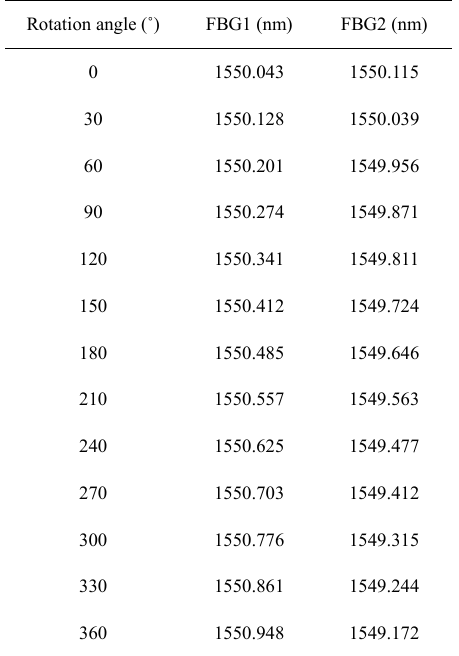
Table 2 Central wavelength experiment data of FBG1 and